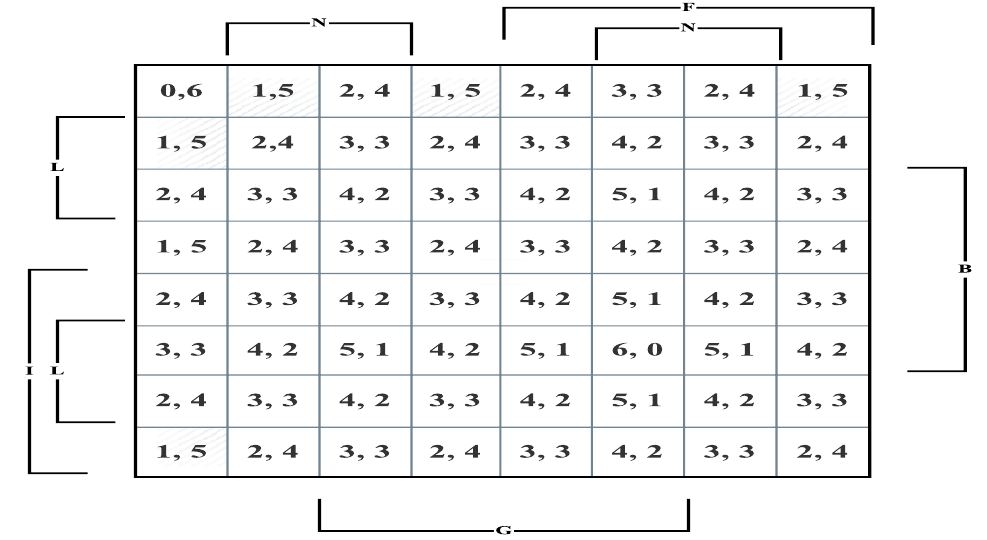
Fig. 4. A six-variable Karnaugh map with every cell characterized by its Hamming distance to the all-0 cell (the empty coalition) and its distance to the all-1 cell (the grand coalition). The sum of these two distances is always